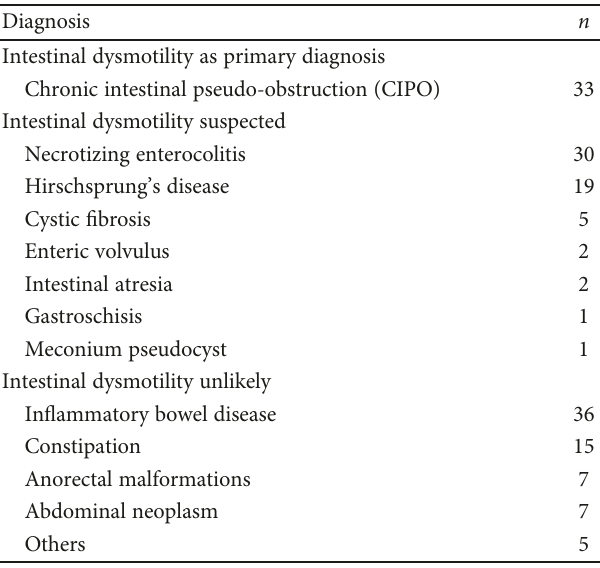
Table 2: Diagnosis leading to stoma creation in 163 patients with ileostomies, by motility